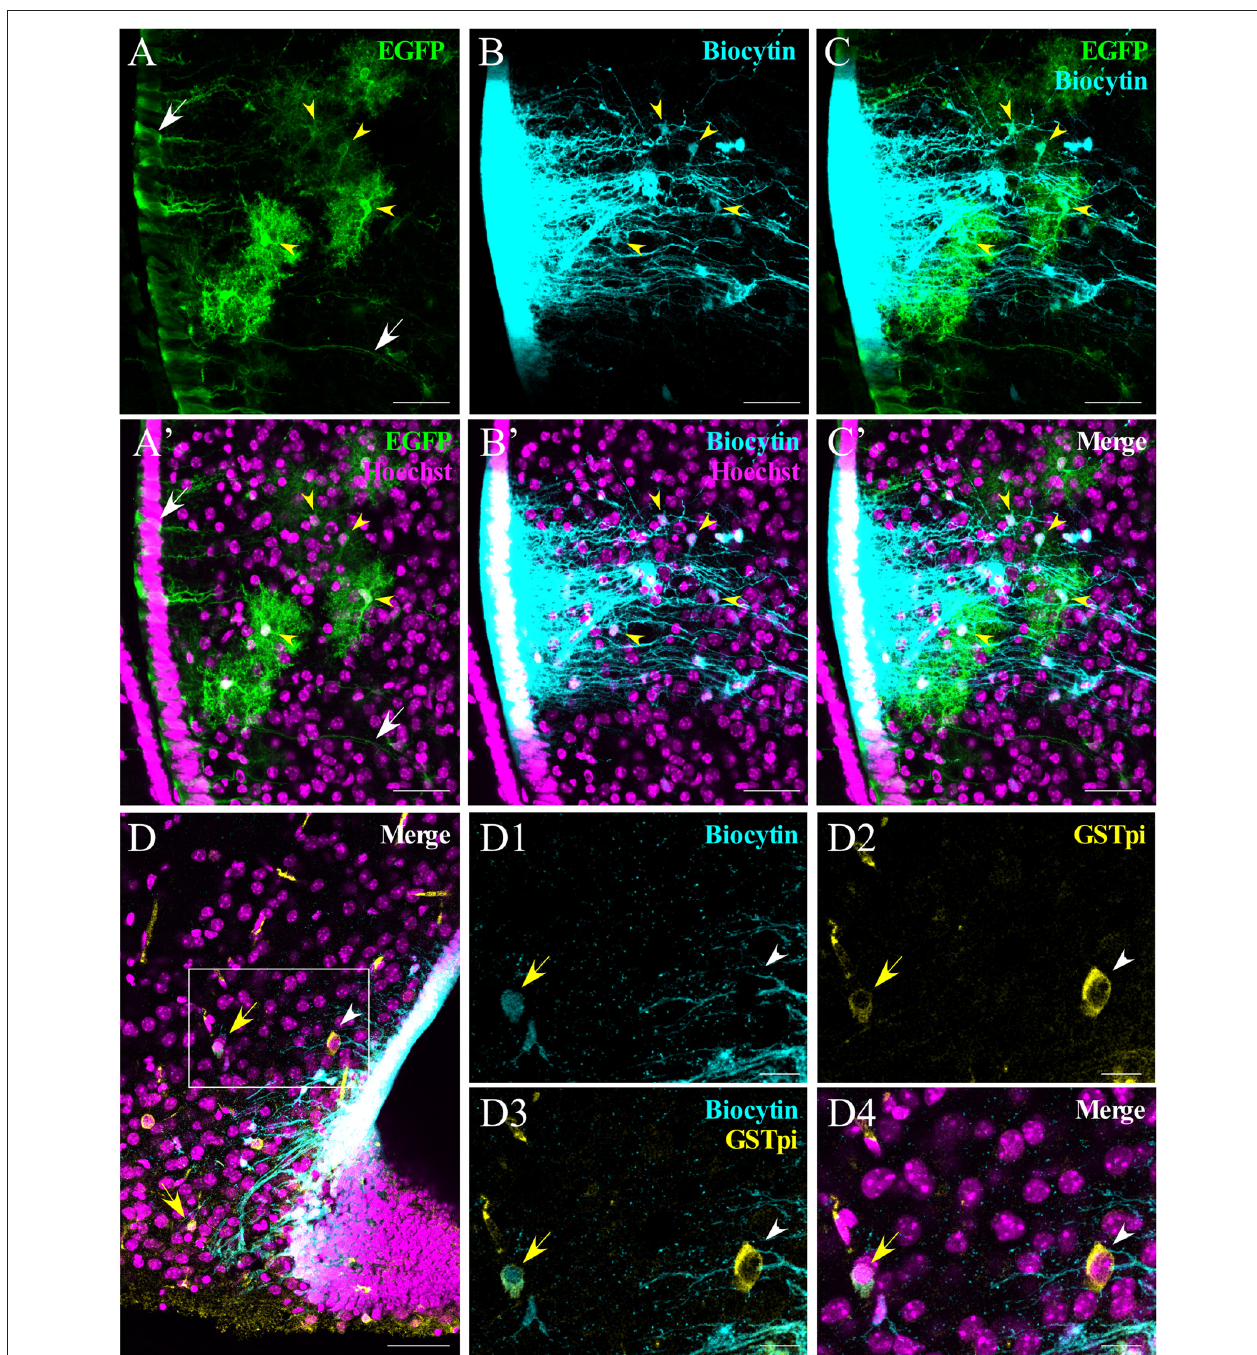
FIGURE 5 | Analysis of α -tanycyte-mediated panglial coupling. α -tanycytes in slices from human GFAP-enhanced green fluorescent protein (hGFAP-EGFP) mice were filled with biocytin to evaluate panglial coupling between tanycytes and astrocytes. (A) Immunohistochemistry against EGFP was performed in order to enhance the signal. White arrows indicate the somata and the processes of EGFP-labeled tanycytes. (B) Biocytin spreads to the neighboring tanycytes and parenchymal cells that co-localize with EGFP-positive astrocytes ( C ; yellow arrowheads). (A’–C’) show the respective images merged with the nuclear staining (Hoechst). (D–D4) Occasionally (in this case, in a Cx30 KO mouse), panglial coupling of the tanycyte with oligodendrocytes was observed. (D) Immunoreaction against GSTpi shows oligodendrocytes close to the ventral part of the hypothalamus. The merged pictures (D,D4) show GSTpi (yellow), biocytin (cyan) and nuclei (Hoechst, magenta). Coupled and non-coupled oligodendrocytes are shown with a yellow arrow and white arrowhead, respectively. (D1–D4) Higher magnifications of (D) , showing biocytin in cyan (D1) , GSTpi in yellow (D2) , the merge of both channels (D3) , nuclei staining in magenta and the merge of all channels (D4) . Scale bar (A–D) : 50 µ m; (D1–D4) : 20 µ